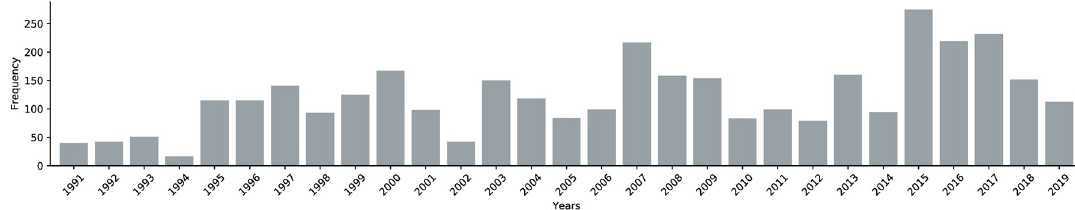
Fig 3. Yearly number of propositions analyzed by the Brazilian Chamber of Deputies between 1991 and 2019. While the number of propositions analyzed along time is not regular, more recently at least 100 propositions were analyzed in each year.